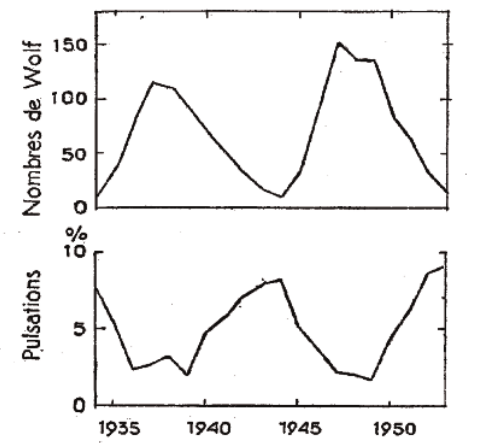
Figure 8. Activité solaire et nombre de pulsations à Kakioka (d’après